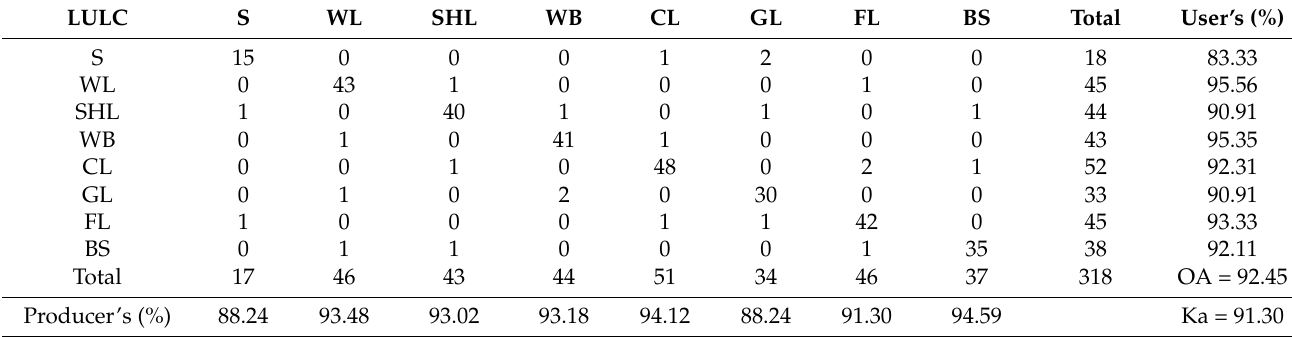
Table 8 shows that, for the reference year 1994, the percentage of overall accuracy and kappa coefficient were 86.06% and 83.61%, respectively. The grey-highlighted diagonal number in the matrix indicated correctly classified pixels for each LULC class, with the yellow cell indicating the total number of correctly classified